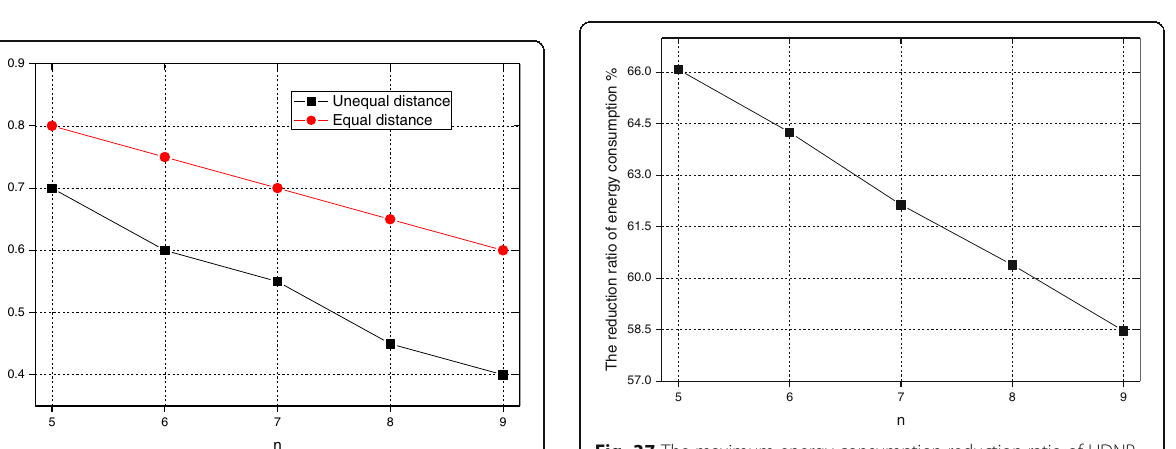
Figure 27 shows the maximum energy consumption of a node in the Grid network when the energy consump- tion of the outermost nodes is the same. In the Grid net- work, the amount of data packets increases, so the gap between the two strategies will also increase. When UDNP uses the optimal duty cycle, the maximum energy consumption is less than half of that of EDNP. Figure 28 is the optimal duty cycle under UDNP and EDNP. In EDNP, when the number of nodes is small, due to the distance of d which is longer compared with 1 that of linear network, the minimum energy consump- tion can be obtained when the duty cycle is maximum. Figure 29 is the maximum energy consumption under UDNP and EDNP. From Fig. 30, it can be seen the maximum energy consumption of UDNP is reduced by more than 58% over that of EDNP [49]. In a Grid network with n = 6, the duty cycle of each node under the MQAM modulation technique is as Table 6 when the lifetime of the Grid network cannot be reduced.